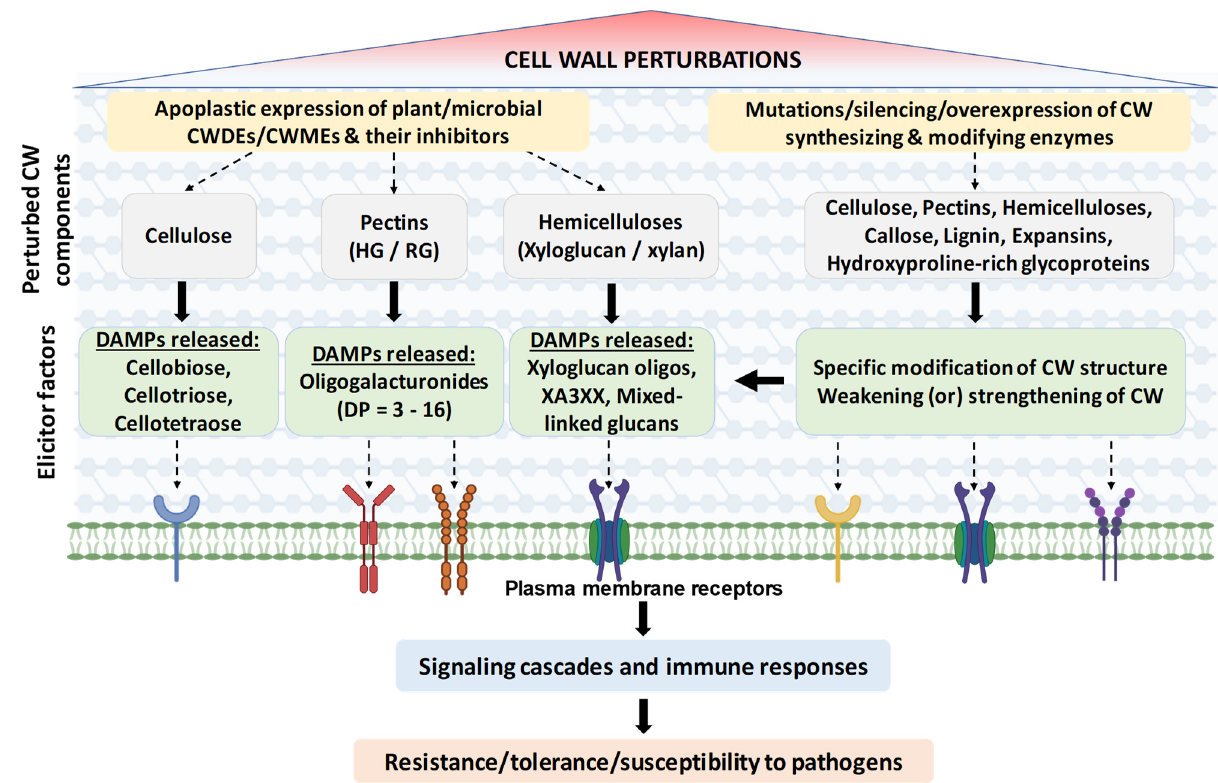
Figure 2. Induced CW perturbations and related signaling. A targeted modification of the CW structures (polysaccharides, phenolics, and proteins) can be achieved by apoplastic overexpression/mutation/silencing the plant endogenous CW synthesizing enzymes, CWMEs, and their inhibitors. As an alternative strategy, exogenous microbial CWDEs can be expressed in the apoplast as well. This results in a different extent of CW perturbations that can result in production of a plethora of DAMPs. DAMPs are perceived by specific receptors to trigger single or multiple defense signaling pathways, which results in different levels of immunity and tolerance/resistance to pathogens. Targeted modification of CW components in planta represents a useful tool to learn about the molecular mechanisms behind CWI maintenance during stress. This knowledge can be exploited to improve crop protection against pathogens.